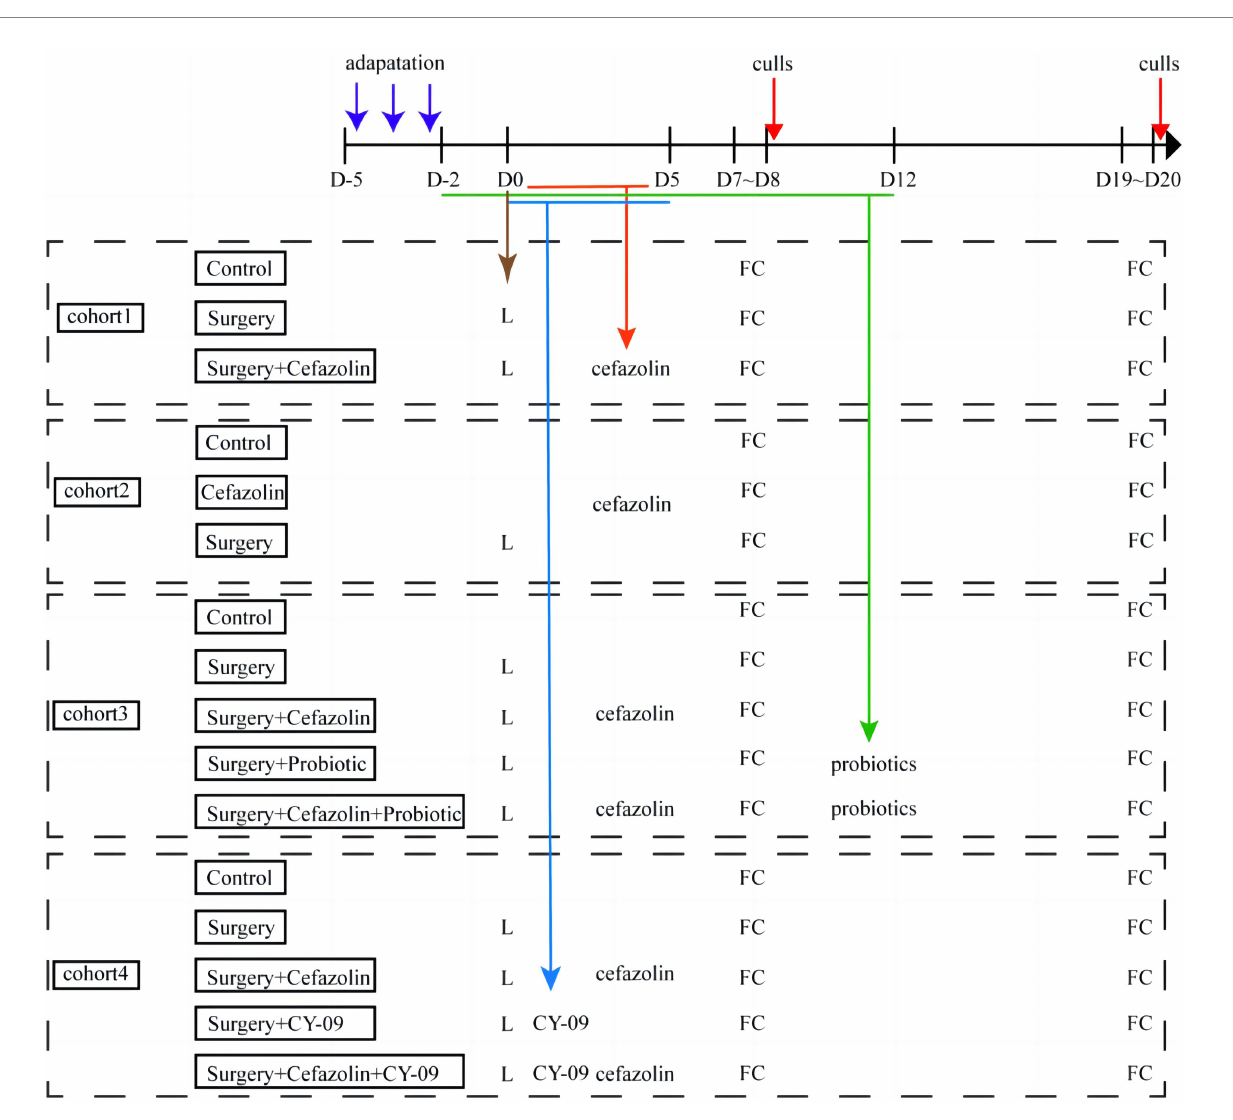
FIGURE 1 Flow diagram of this study. D, day; L, laparotomy; FC, fear conditioning test ( n = 20 per